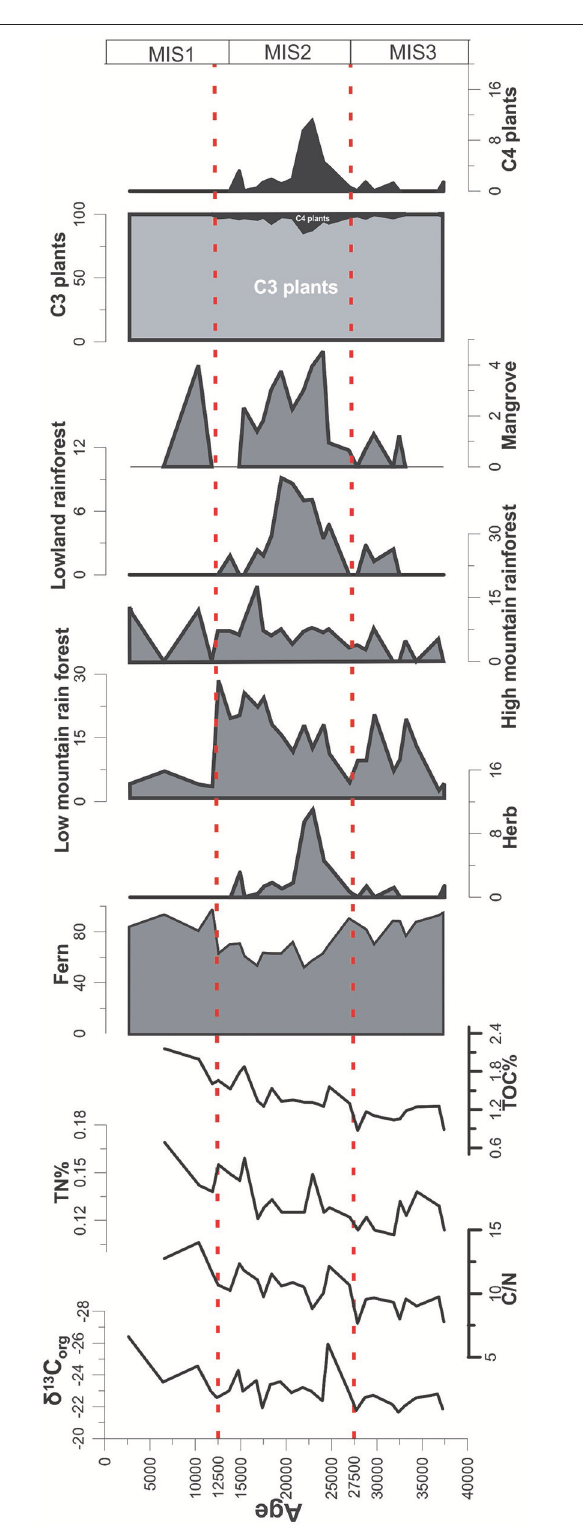
FIGURE 5 | Diagram of simplified pollen percentage and the distribution of geochemical proxies of the NS07-25 core.